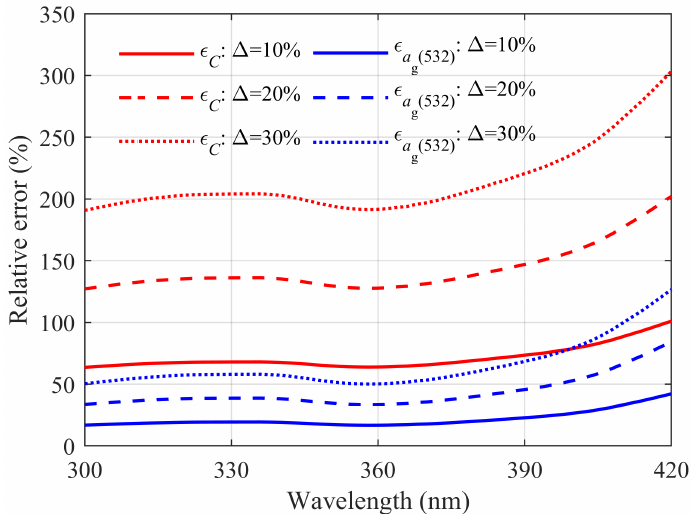
Figure 6. Relative errors of chlorophyll (red lines) and CDOM absorption (blue lines) in di ff erent ∆